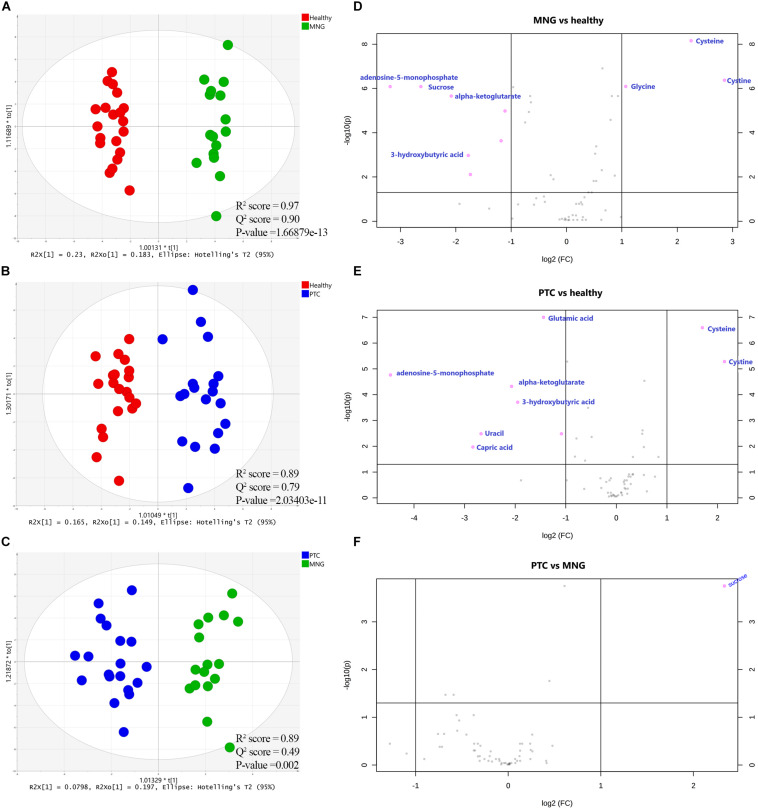
(A–C) Supervised (OPLS-DA) analysis score scatter plots illustrating that the metabolic profiles of PTC is distinct from healthy, MNG is distinct from healthy and MNG is distinct from PTC. (D–F) Volcano plots of the most significant metabolite changes comparing healthy vs. MNG (D), healthy vs. PTC (E), and PTC vs. MNG (F). The most significant differences in metabolites presence; pink dots and the gray dots represent metabolites with no significant differences. The pink dots on the left represent metabolites above the thresholds and their intensities were increased while the pink dots on the right were the opposite. x-axis corresponds to log2 (Fold Change) and y-axis to −log10 (p-value). OPLS-DA; orthogonal partial least squares-discriminant analysis, PTC; papillary thyroid carcinoma, MNG; multinodular goiter.